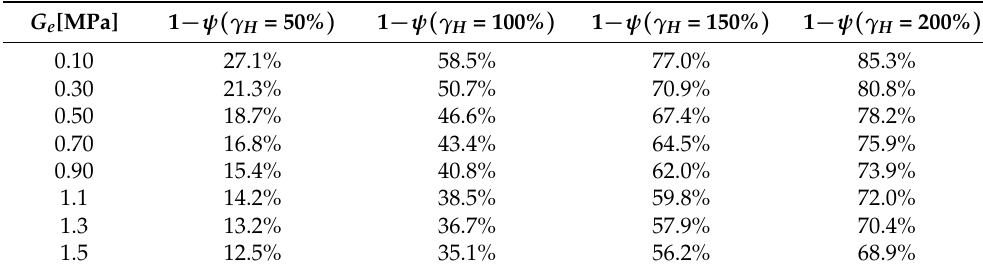
Table 3. Percentage reduction of the ψ function with the shear strain for different values of the shear modulus of the